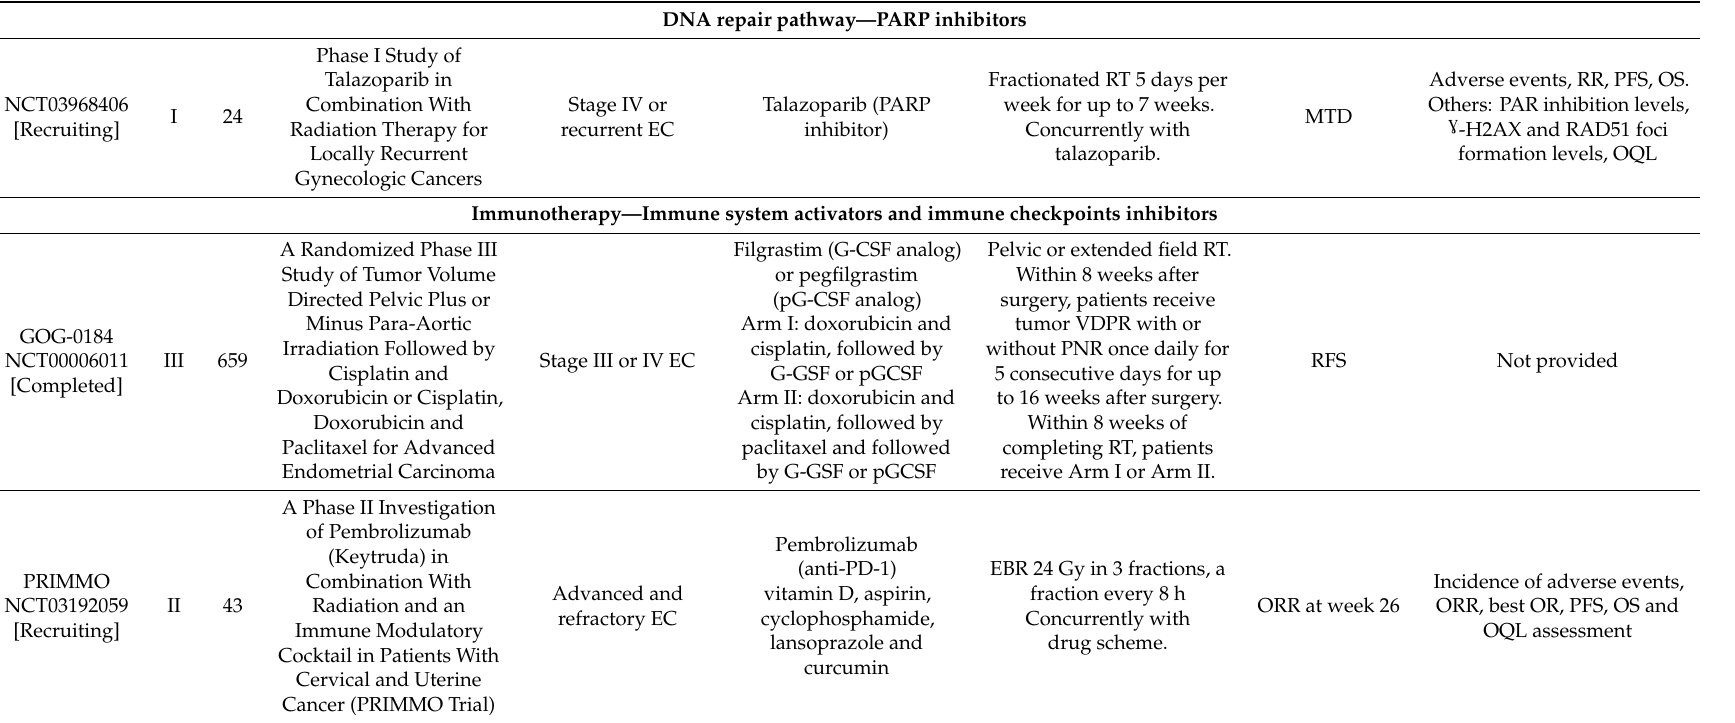
DNA repair pathway—PARP